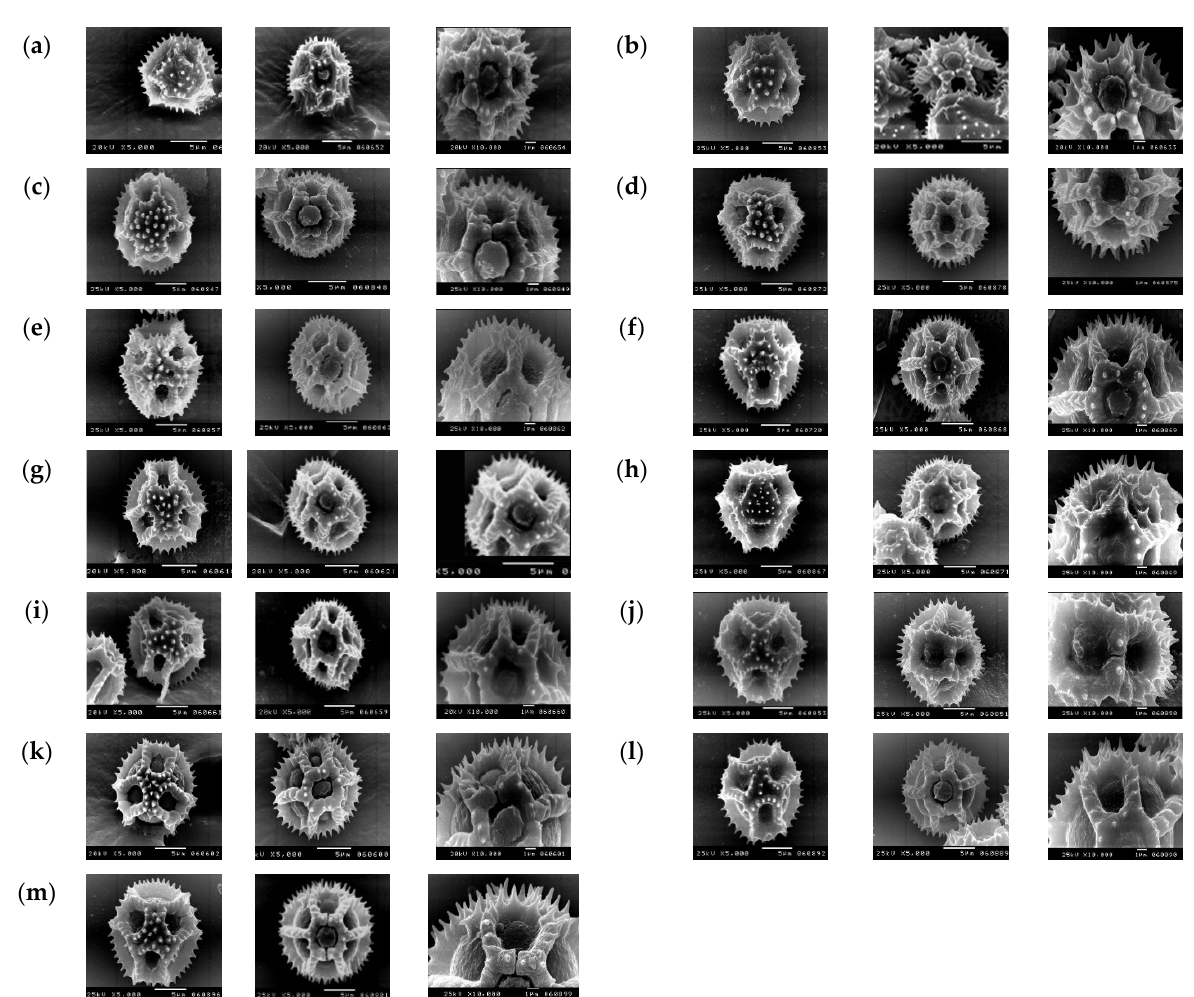
Figure 8. SEM micrographs of pollen grains for polar view (left), equatorial view (middle) and paraporal ridge ornamentation (right) for each taxon. ( a ) Reichardia tingitana , spiny-granulate. ( b – m ) Launaea : ( b ) L. spinosa , spiny; ( c ) L. capitata , spiny-perforate; ( d ) L. intybacea and ( e ) L. massauensis , spiny-perforate; ( f , g ) L. nudicaulis : ( f ) group 6, spiny-perforate; ( g ) group 7, spiny; ( h ) L. angustifolia subsp. angustifolia , spiny-perforate; ( i ) L. angustifolia subsp. arabica , spiny; ( g – k ) L. fragilis subsp. fragilis , ( g ), group 13, spiny-granulate, ( k ), group 17, spiny-perforate; ( l ) L. mucronata subsp. cassiniana , spiny; ( m ) L. mucronata subsp. mucronata , spiny-perforate.